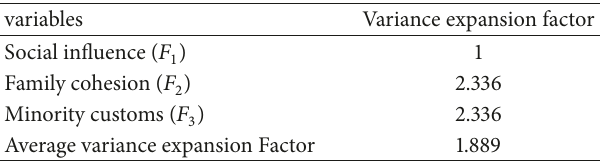
Table 5: Variance expansion factor of three